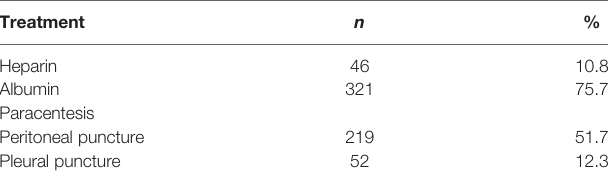
TABLE 1 | Conventional intervention for ovarian hyperstimulation syndrome (OHSS).